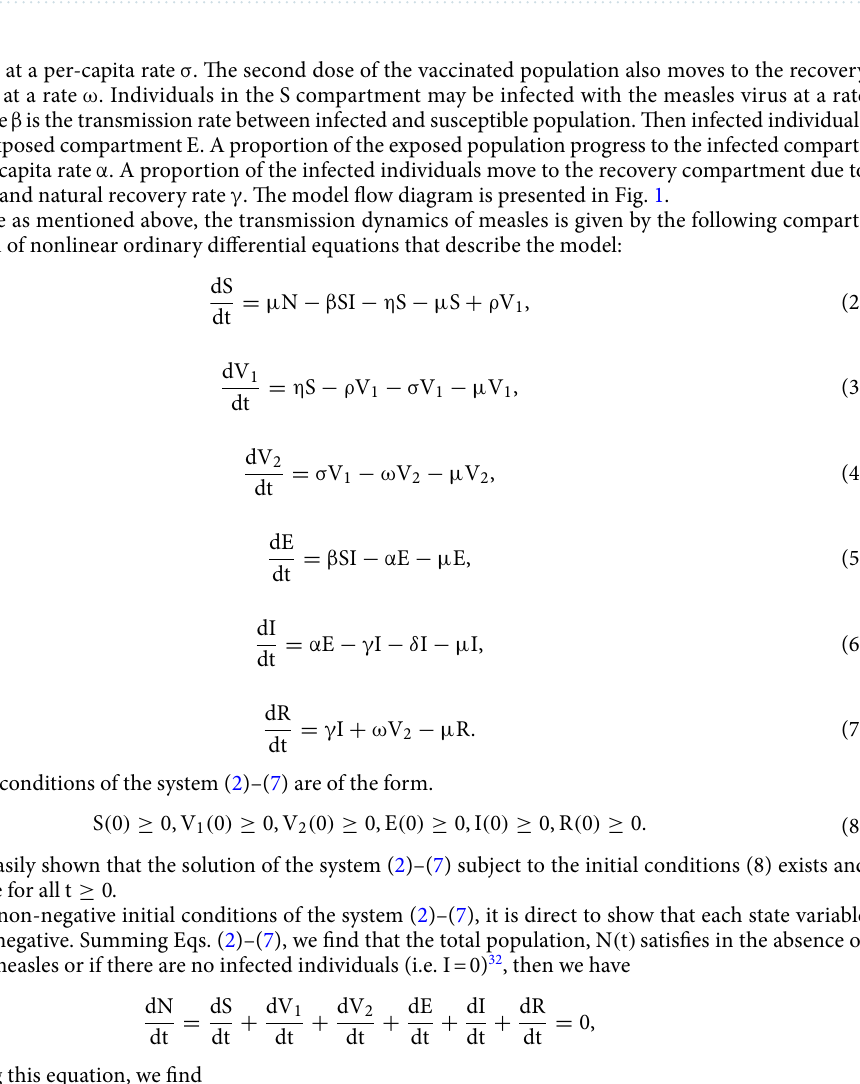
Figure 1. Schematic diagram of measles model for Bangladesh measles